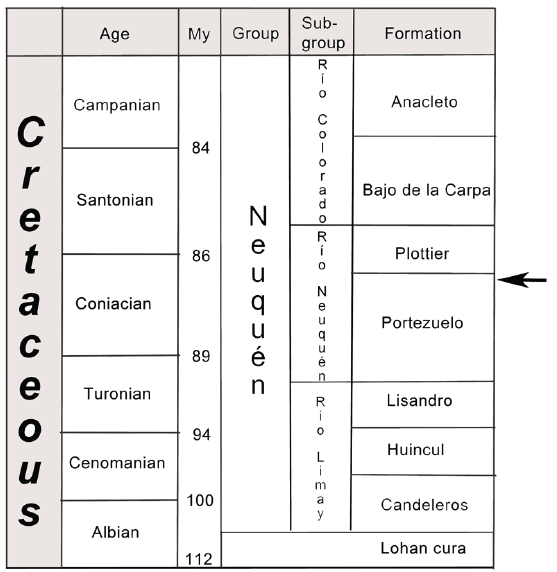
Figure 2 - Stratigraphic column of the Neuquén Group showing the age of Baalsaurus mansillai n.g.n.sp. (arrow). My, millions of years. (modified from Calvo et al.